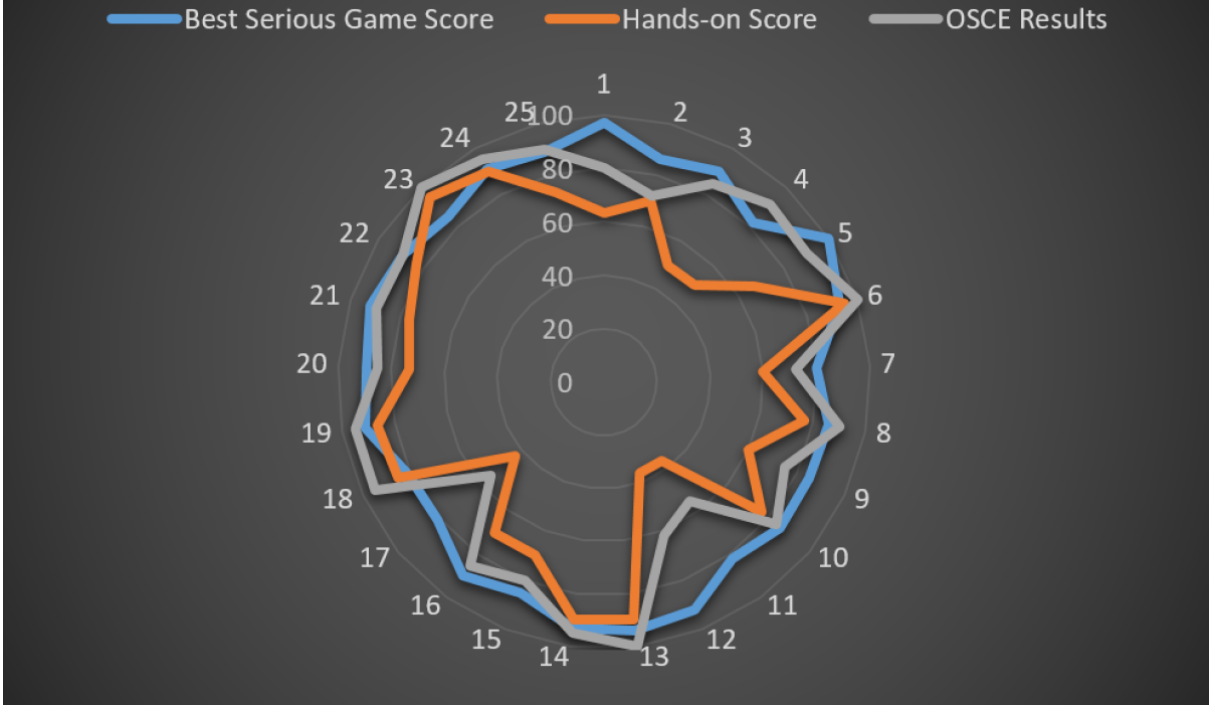
Table 4. Correlation analysis of serious game, hands-on training app, and OSCE scores a . Success on which trial (score ≥ 80)